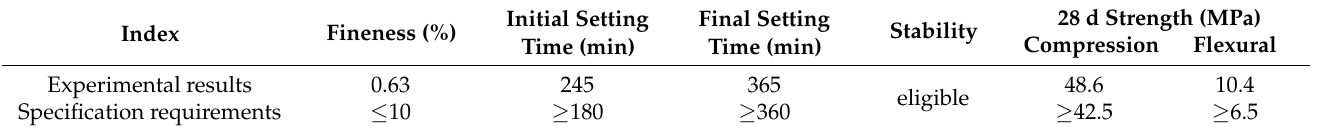
Table 1. Technical index test results of